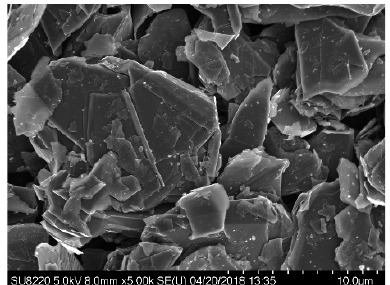
Figure 1. SEM microtopography of graphite powder.